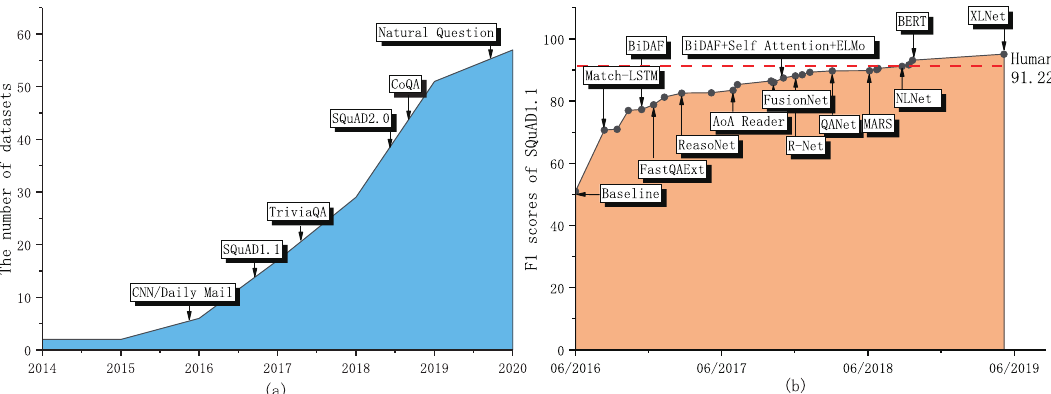
Figure 3. The number of MRC datasets created in recent years and the F1 scores of state-of-the-art models on SQuAD 1.1 [19]: ( a ) The cumulative number of MRC datasets from the beginning of 2014 to the end of 2019. ( b ) The progress of state-of-the-art models on SQuAD 1.1 since this dataset was released. The data points are taken from the leaderboard at